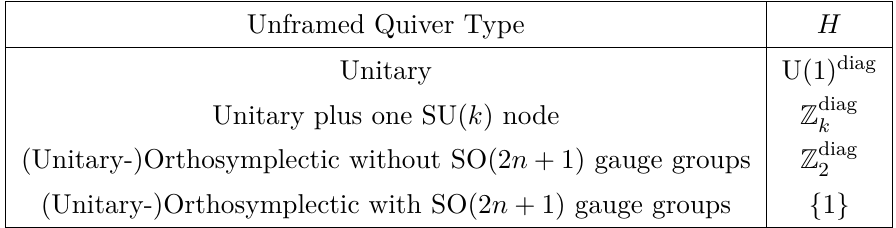
Table 1. Maximal subgroups H of the product group G of different types of unframed simply laced